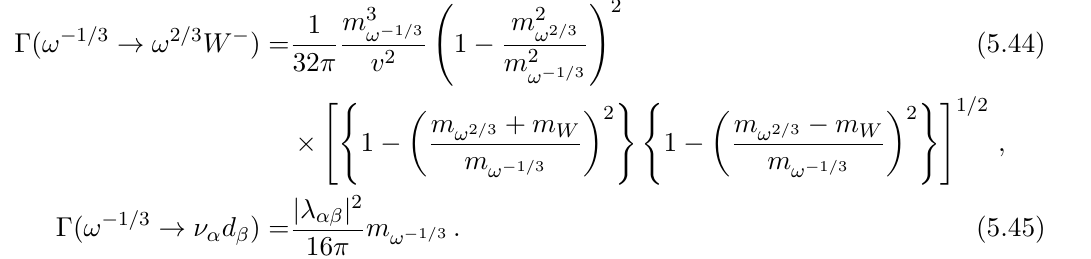
! 2 = 3 + W (cid:0) and ! (cid:0) 1 = 3 !